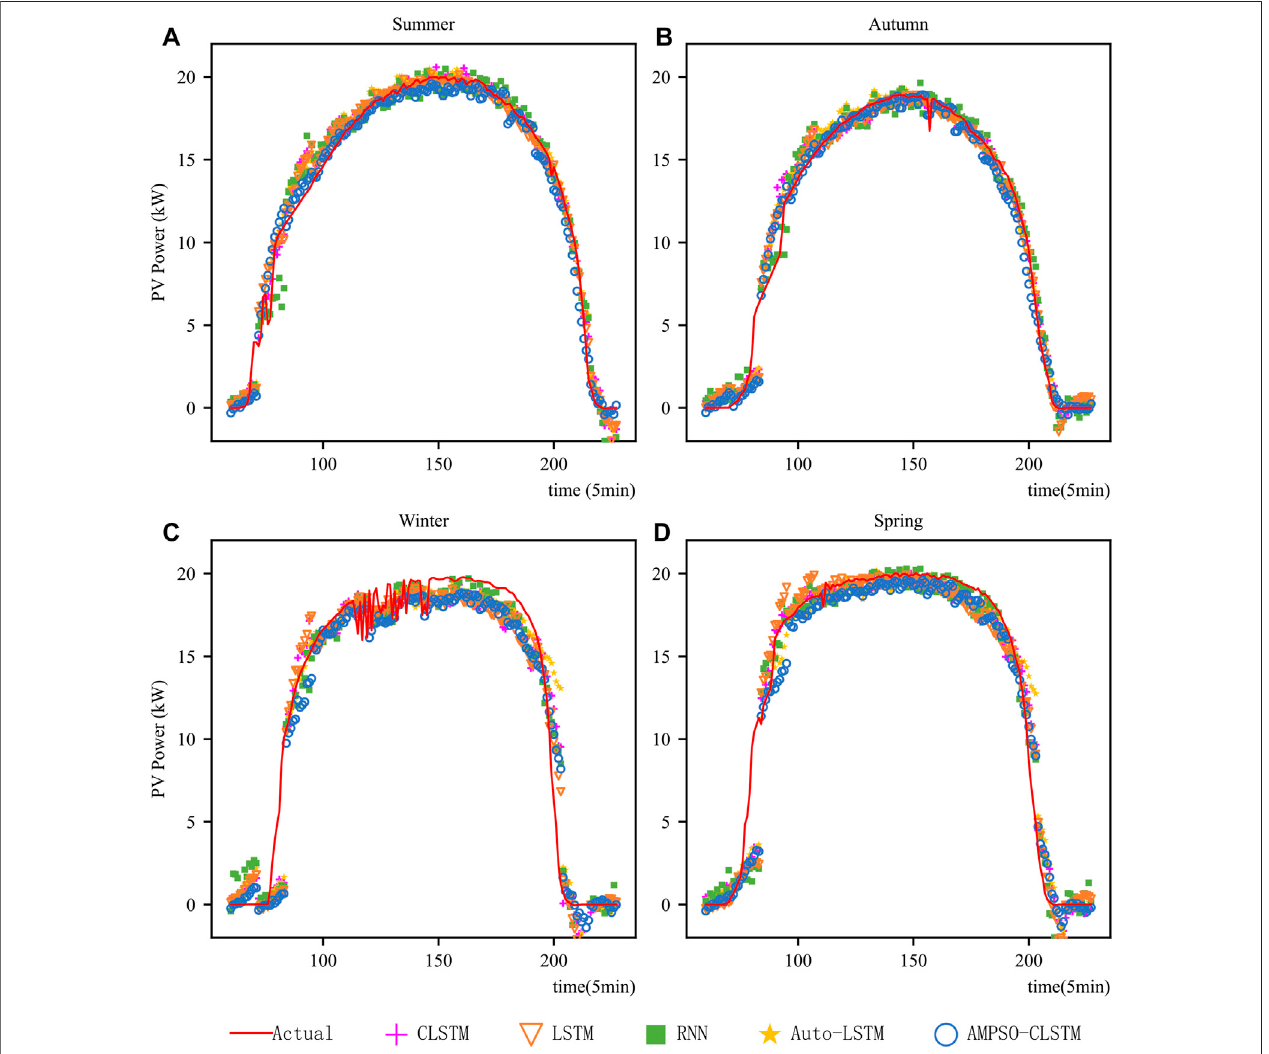
FIGURE6| Forecastingresultsforawholedayineachseason. (A-D) respectivelyshowtheforecastresultsofallthemodelsinspring,summer,autumnandwinter.